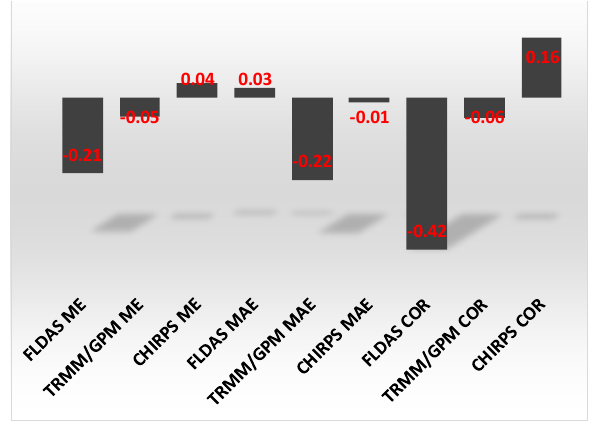
Figure 13. Bar graph of the correlations between elevation and accuracy statistics for the various satellite/interpolated precipitation products.